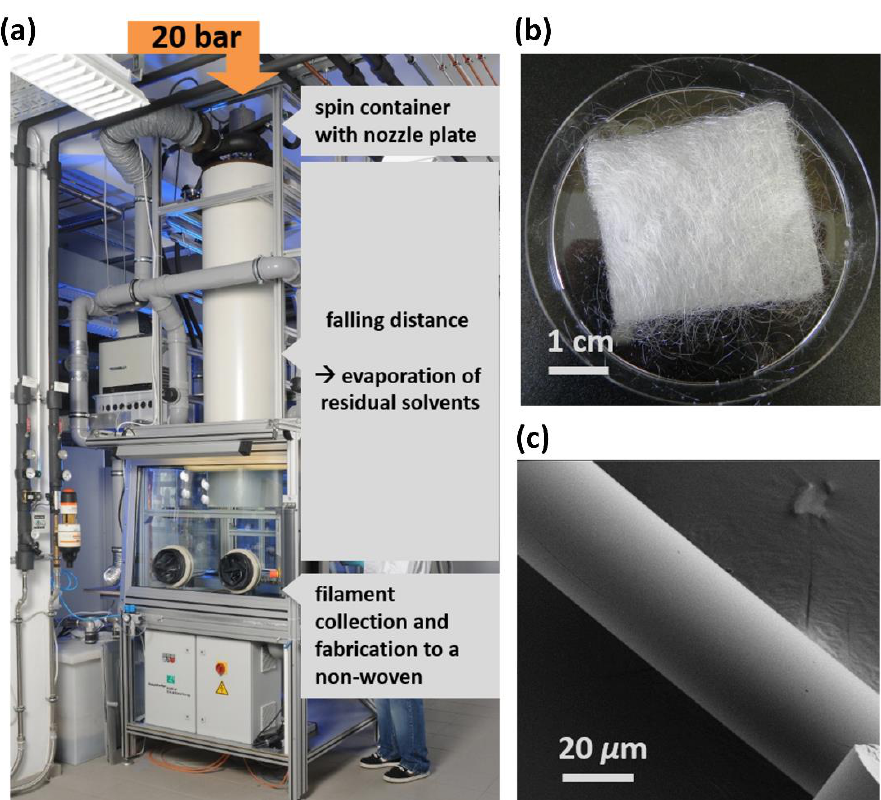
Figure 1. Picture of the spinning plant ( a ) and a non-woven fiber fleece 1 ( b ); SEM image of 1 with a fiber diameter of 30 µm and a smooth surface area ( c ).